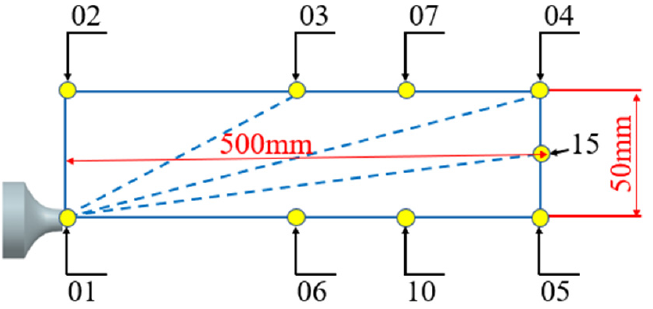
Figure 2. Layout of near-field monitoring points of the equal-diameter nozzle and standard noz- zle.